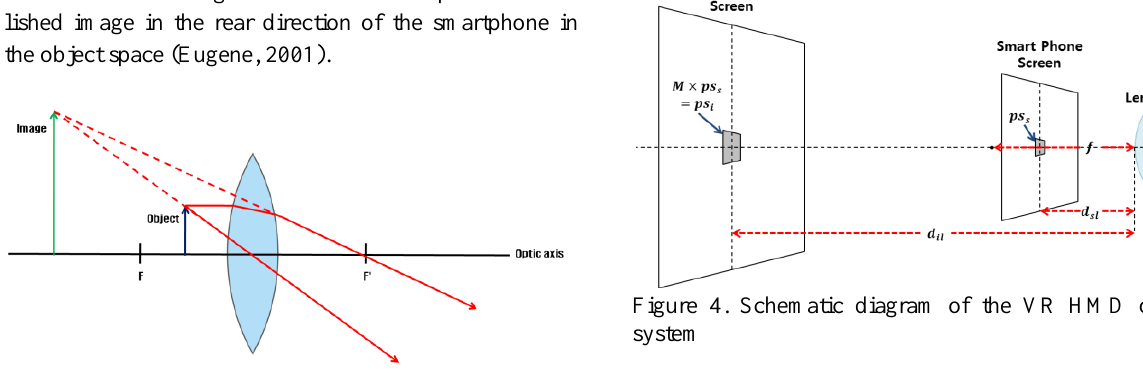
Figure 2. Image formation on the convex lens of the VR HMD VR HMD parameters